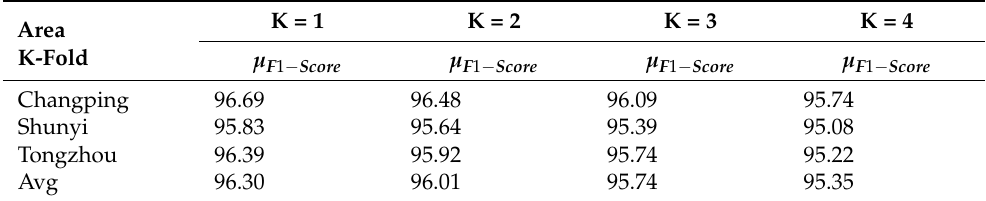
Table 5. The classification reports generated from 5-fold. K = 1 represents the highest number of training images (12,900), and K = 4 represents the lowest number of training images (3440). The average F 1 − Score is reported for each district obtained with the ShuFormer-base